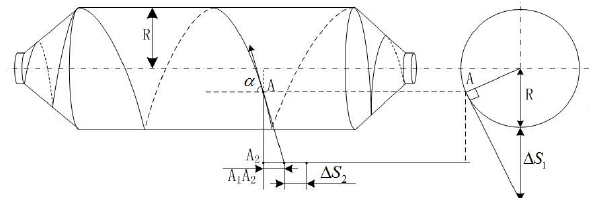
Figure 8: The sketch of the winding